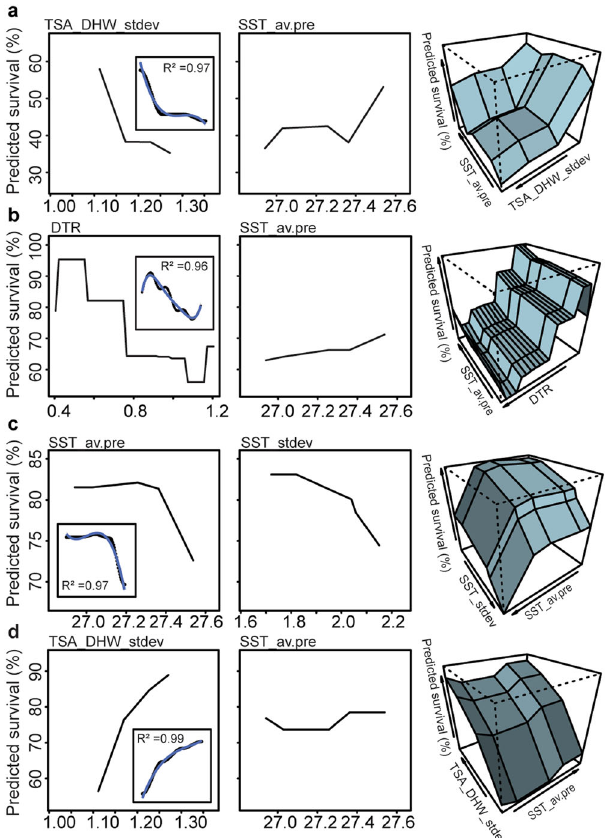
Fig. 4 Forecasting models developed to locate reefs harbouring corals capable of producing heat-tolerant offspring. Gradient Boosted Model (GBM) partial plots of the most important parameter coef fi cients for aposymbiotic larvae ( a , b ) and juveniles infected with Durusdinium trenchii ( c , d ). Parameters for each plot are listed in the top right-hand corner, demonstrating the predicted percent (%) survival ( y -axis) for each model. 3-D plots show the interactive effect of each parameter estimates per life- stage and symbiont combination for predicting percent survival (blue shading to more easily show contours). Resulting intrinsic resistance models (insets, a – d ) produced from GBM partial plots were used to calculate environmental conditions for optimal survival and represent the most important predictors with a corresponding goodness of fi t value ( R 2 , blue line). Intrinsic resistance models capitalize on the heritability of heat tolerance, symbiotic-state, and adult environmental conditions. The abbreviations follow- SST_av.pre: average sea surface temperature between 2014 and 2016 before mass bleaching, DTR: daily temperature range, TSA_DHW_stdev: standard deviation of thermal stress anomaly calculated in degree heating weeks, and SST_stdev: standard deviation of average daily sea surface